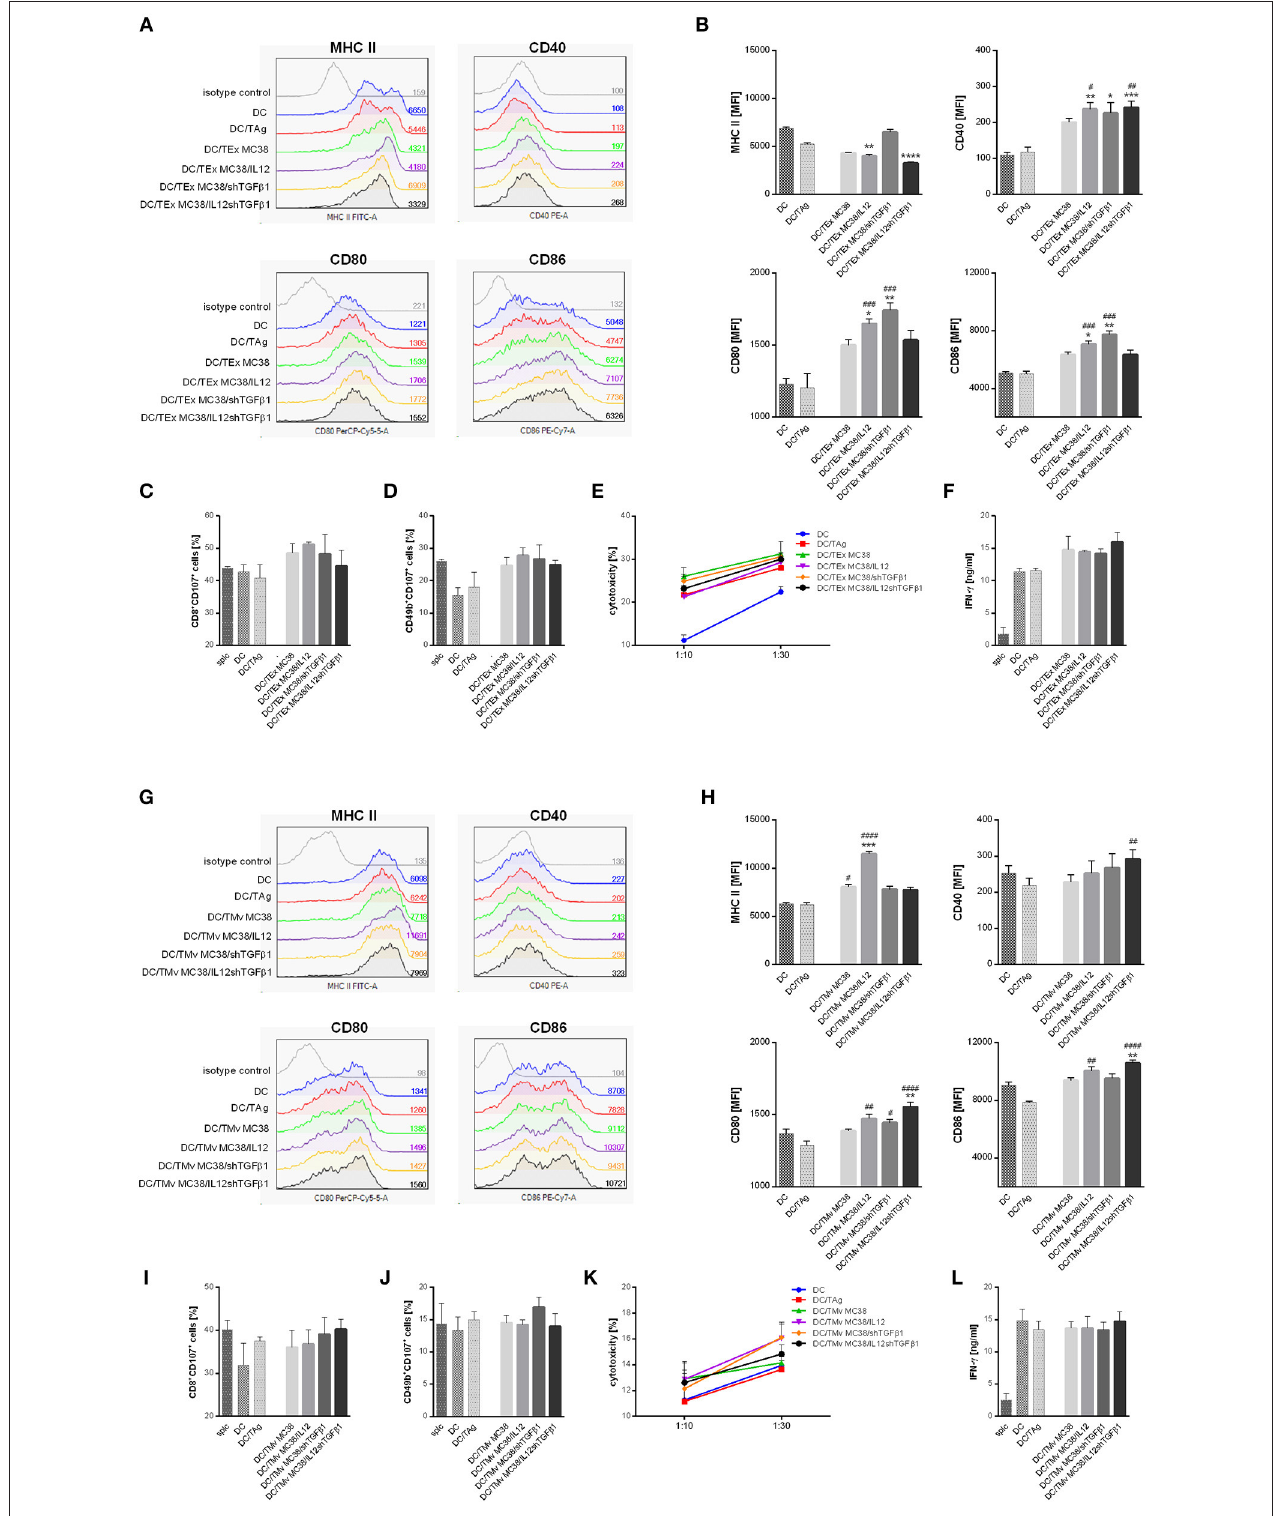
FIGURE 3 | The influence of TEx or TMv isolated from wild-type MC38 cells or MC38 cells with overexpression of IL-12 and/or shTGF β 1 on dendritic cell (DC) activity in vitro . (A,B) Representative histograms and bar plots showing phenotypic changes of DCs after 24-h stimulation with TEx. (C–F) Splenocyte activity after primary